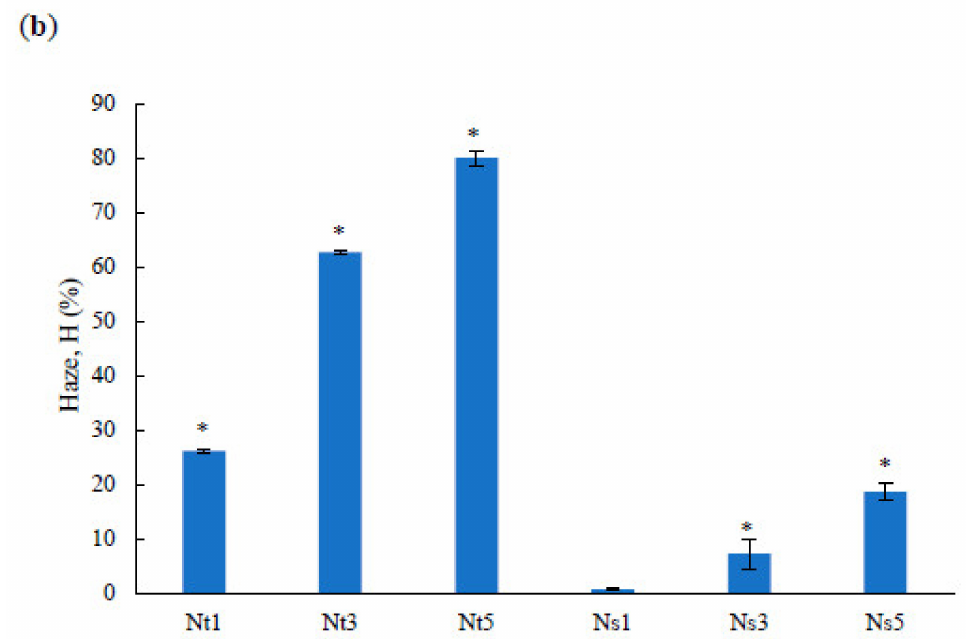
Figure 4. Optical properties (percentage differences compared to samples without biocide): ( a ) trans- parency; ( b ) haze. Statistically significant differences ( p < 0.05) compared to the control (0) are marked with asterisks. Abbreviations: as in Figure